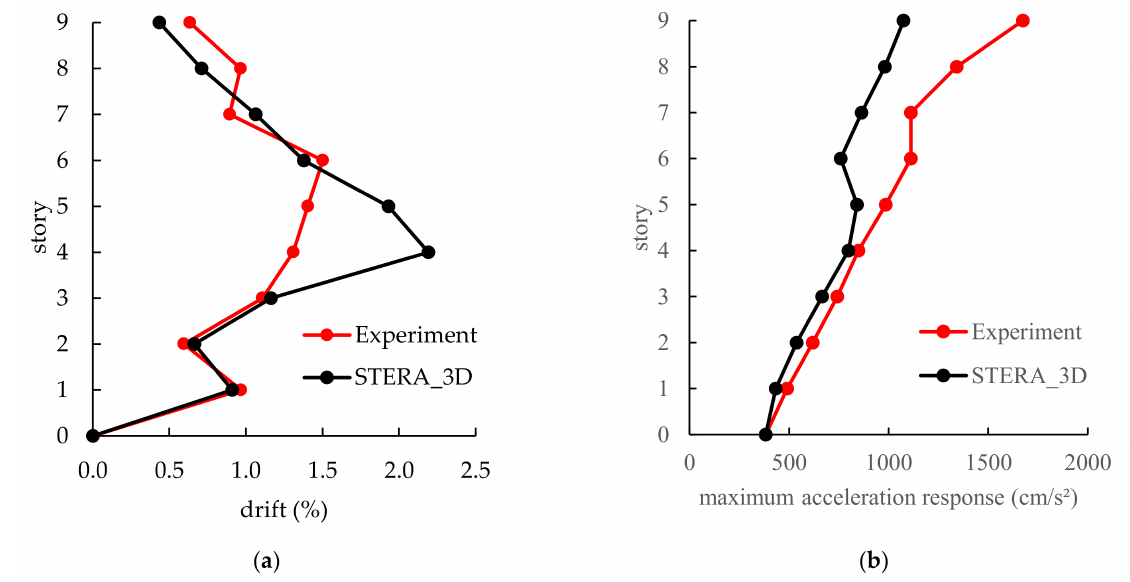
Figure 7. Comparison of experiment of towered setback structure with STERA_3D response: ( a ) interstory drift; ( b ) maxi- mum acceleration.